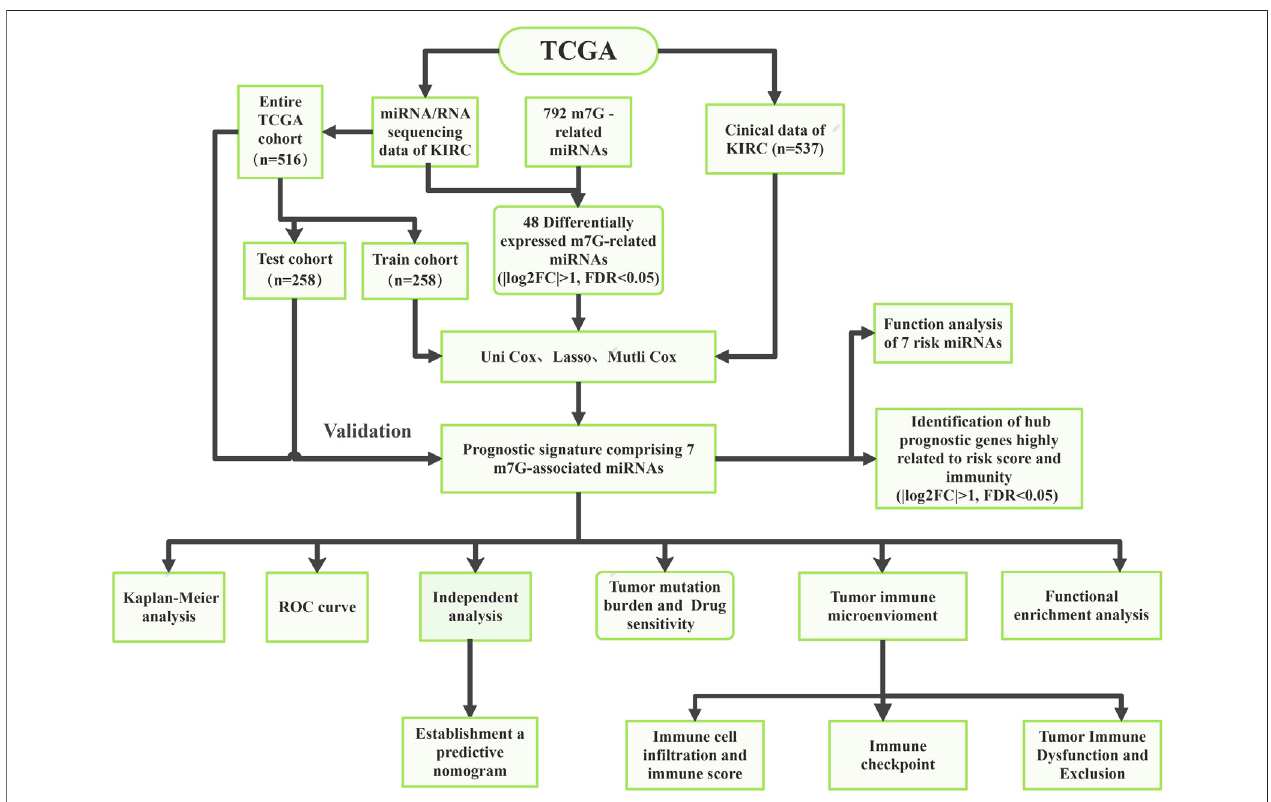
FIGURE 1 | The fl ow chart of this